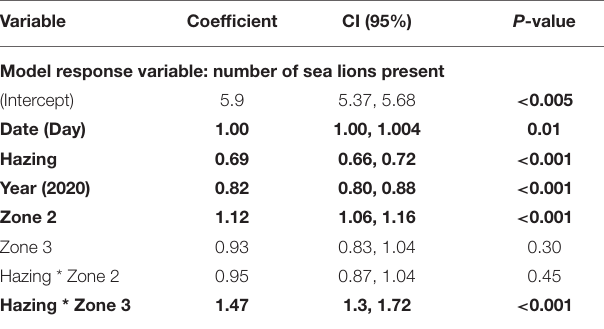
TABLE 3 | General linear model predicting the factors influencing the number of SSL present at Bonneville during observation.